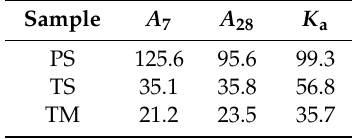
Table 2. Hydraulic activity test of slag (%).